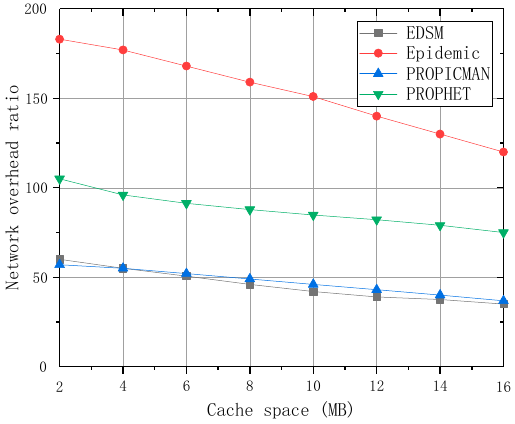
Figure 8. Average message delay in different cache spaces. Electronics 2020 , 9 , x FOR PEER REVIEW